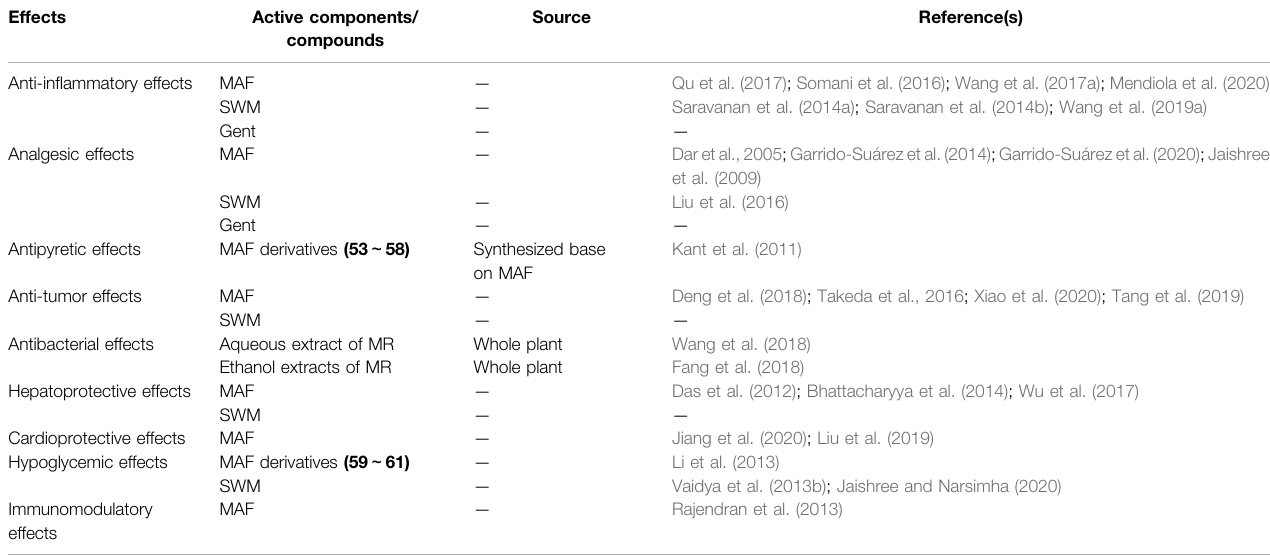
TABLE 3 | Pharmacological effects of extracts and compounds from